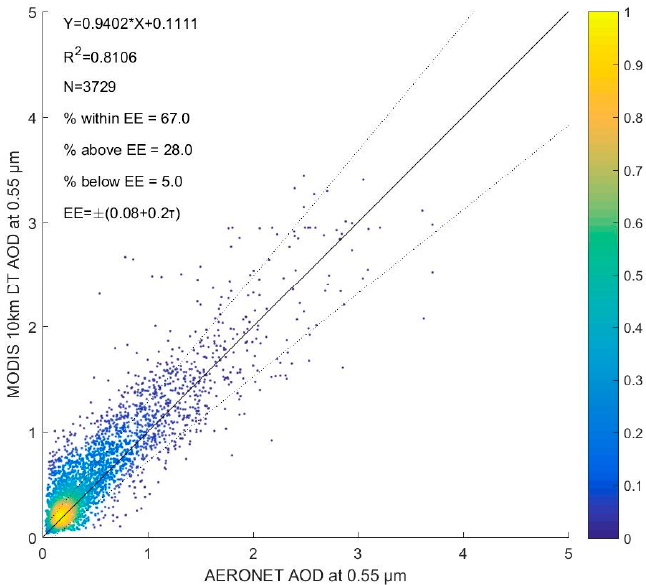
Figure 2. Validation of the Moderate Resolution Imaging Spectroradiometer (MODIS; both Terra and Aqua) 10 km Dark Target aerosol optical depth (DT AOD) against AERONET measurements at the Beijing station and Beijing-CAMS station. EE: expected error.